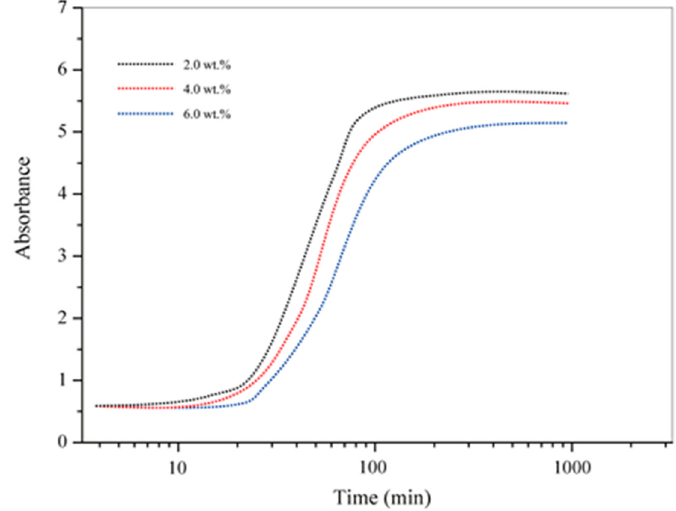
Figure 7. Absorbance-time curves of 843 cm − 1 band at 30 °C with the microcapsules contents of 2.0, 4.0 and 6.0 wt %.